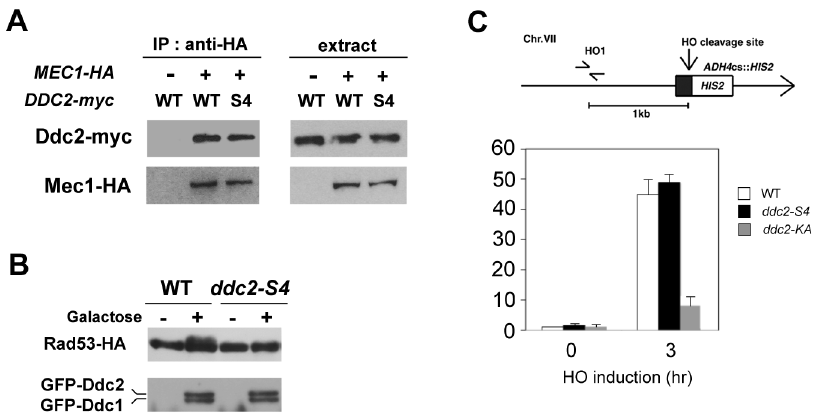
Figure 4. Effect of ddc2-S4 on Mec1-Ddc2 interaction and Mec1 localization. (A) Effect of ddc2-S4 mutation on Mec1-Ddc2 interaction. MEC1- HA ddc2 D (KSC1340) or ddc2 D (KSC1234) cells were transformed with YCp-DDC2-myc or YCp-DDC2-S4-myc. Extracts prepared from cells were subjected to immunoprecipitation with anti-HA antibodies. Immunoprecipitates and whole extracts were analyzed by immunoblotting with anti-HA or anti-myc antibodies. (B) Effect of ddc2-S4 or ddc2-KA mutation on Mec1 localization to an HO-induced DSB. Wild-type (KSC1635), ddc2-S4 (KSC2158) or ddc2-KA (KSC2159) cells expressing Mec1-HA were transformed with the YCpA-GAL-HO plasmid. Transformed cells were grown in sucrose and treated with nocodazole. After arrest at G2/M, the culture was incubated with galactose for 3 hr to induce HO expression, while half of the culture was maintained in sucrose to repress HO expression. (Top) The strains contain an HO cleavage site, marked with HIS2 , at the ADH4 locus on chromosome (Chr.) VII. The HO1 primer pair amplifies a region 1 kb away from the HO cleavage site. An arrow represents the telomere. (Bottom) Cells were subjected to chromatin immunoprecipitation with anti-HA antibodies. Association of Mec1 with an HO-induced DSB was analyzed by real-time PCR. Relative enrichment was determined from three independent experiments. (C) Effect of ddc2-S4 on Rad53 phosphorylation after co-localization of Ddc1-LacI and Ddc2-LacI to a LacO array. Cells containing the LacO 256 array and RAD53-HA with the combination of DDC1-LacI-GFP and DDC2-LacI- GFP (CBY88) or DDC2-S4-LacI-GFP (KSC2419) under the control of GAL promoter were grown in sucrose and arrested in nocodazole for 2 hr. Galactose was pulsed for 2 hr, and then cells were further incubated with glucose. Samples were collected at 2 hr after addition of glucose and subjected to immunoblotting analysis with anti-HA or anti-GFP